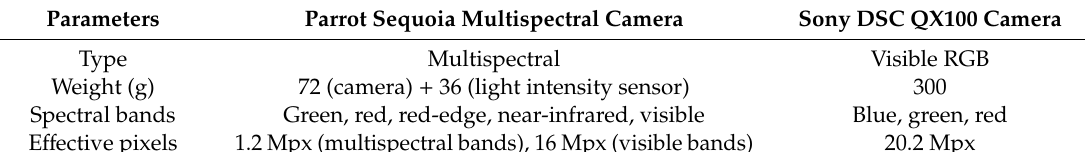
Table 1. Characteristics of the cameras used to obtain the unmanned aerial vehicle (UAV) images.